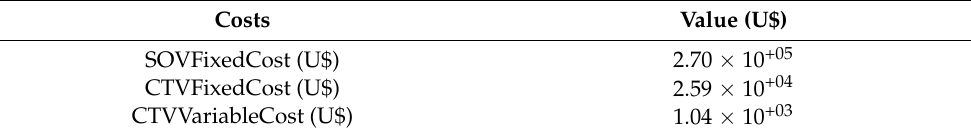
Figure 4. Graphical representation of the routing solutions. Table 4. Infrastructure costs.